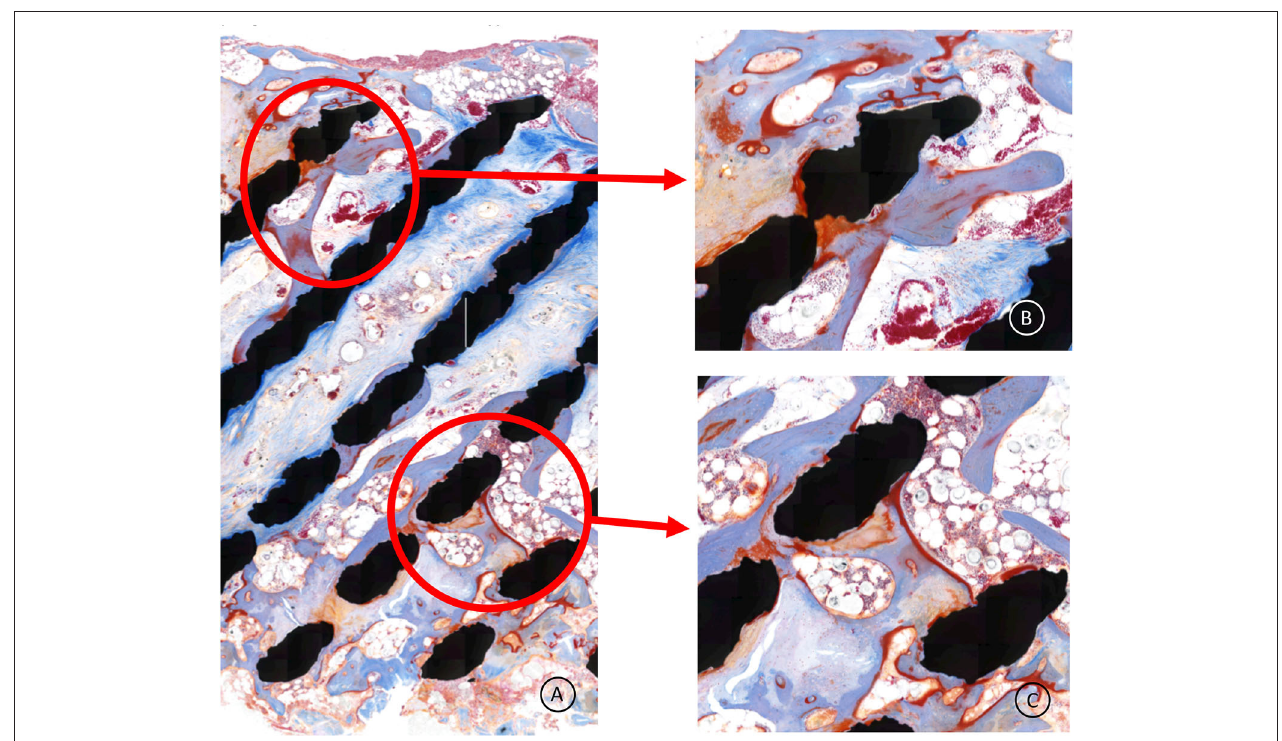
FIGURE 7 | (A–C) Higher magnification of the cage central part; the bone (light blue) is remodeling, demonstrating adaptive reactivity. The red lining is osteoid, indicating active bone apposition by osteoblasts. No signs of inflammation are present. The whitisch bullous tissue is healthy bone